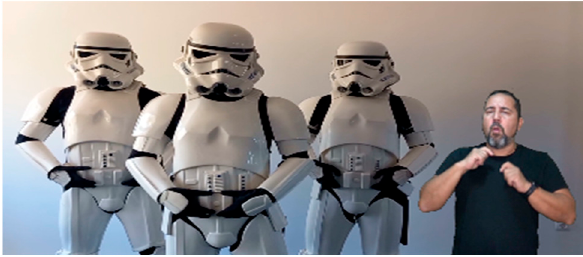
Figure 1. Screenshots of the missions (Tatooine).